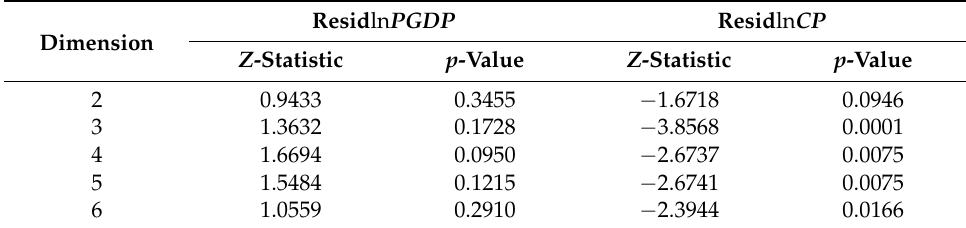
Table 2. BDS nonlinear effect test result based on VAR model